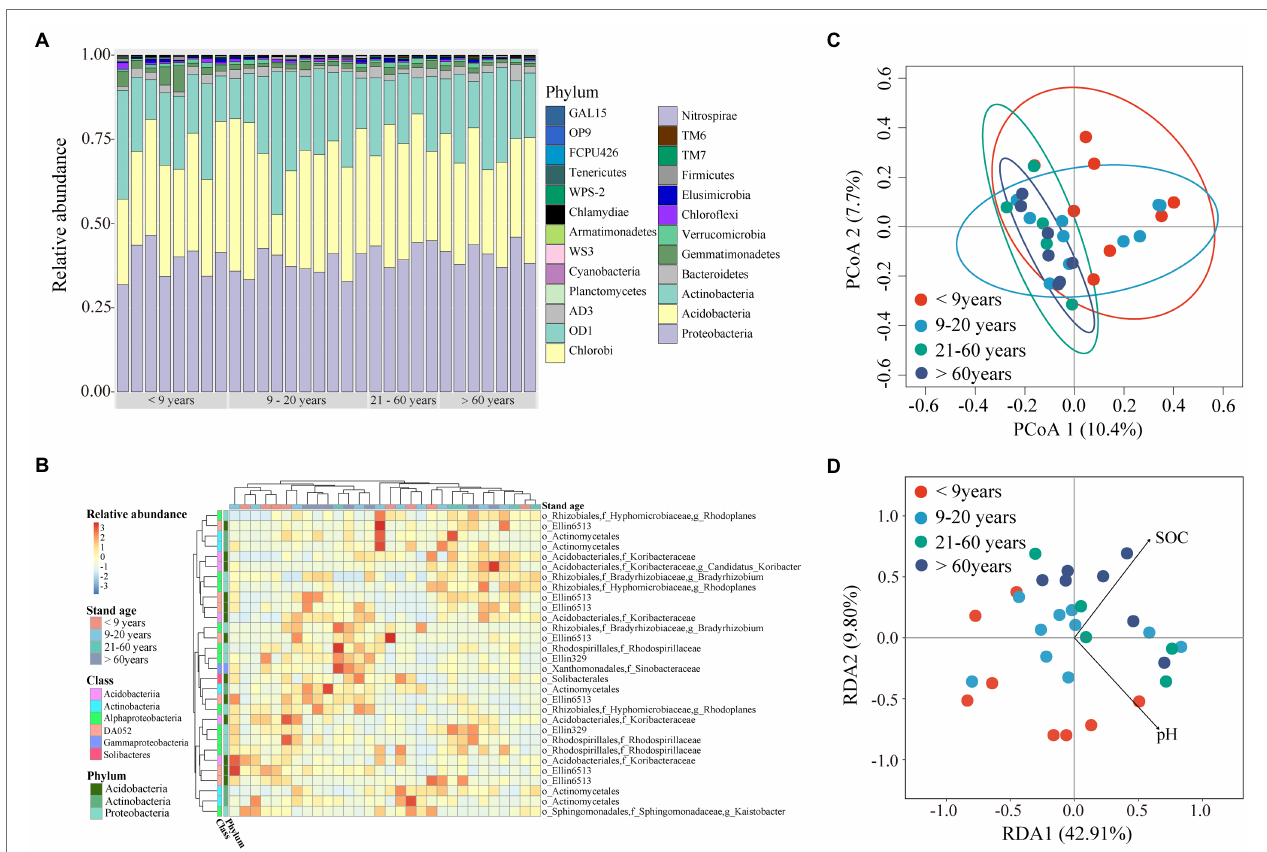
TABLE 1 | Significance test of the differences of centroids with the succession age. a